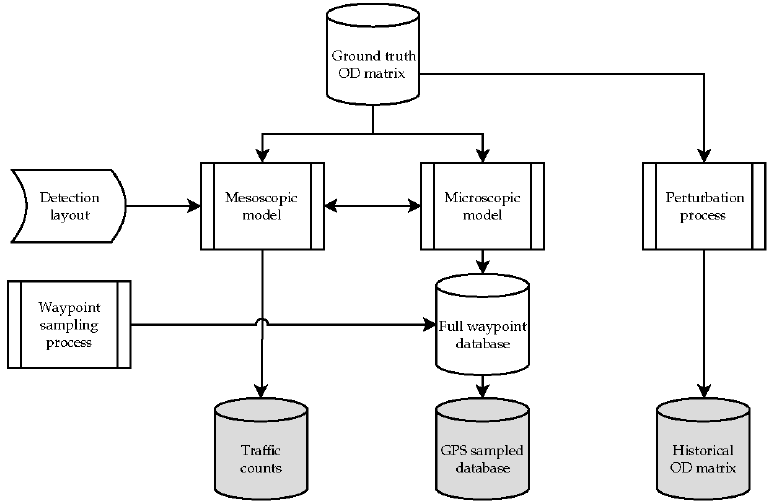
Figure 2. Conceptual diagram of the synthetic data generation for computational testing.